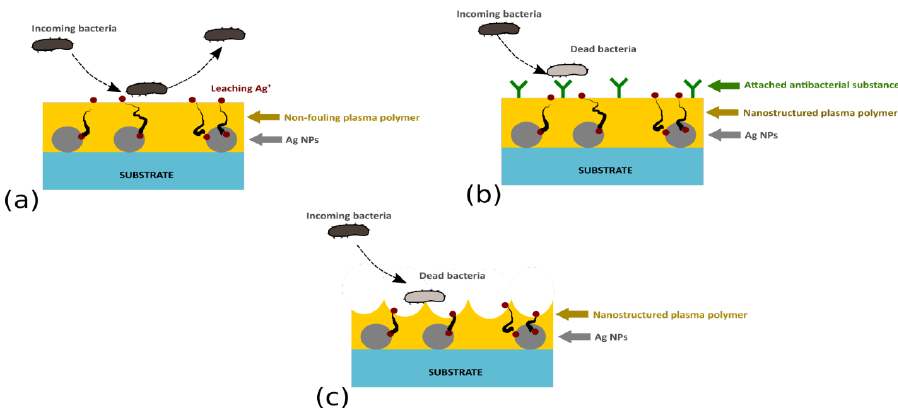
Figure 6. Ag-based multi-functional coatings with ( a ) non-fouling character, ( b ) Ag/plasma polymer nanocomposites with covalently immobilized antibacterial agents, or ( c ) a nanostructured plasma polymer top